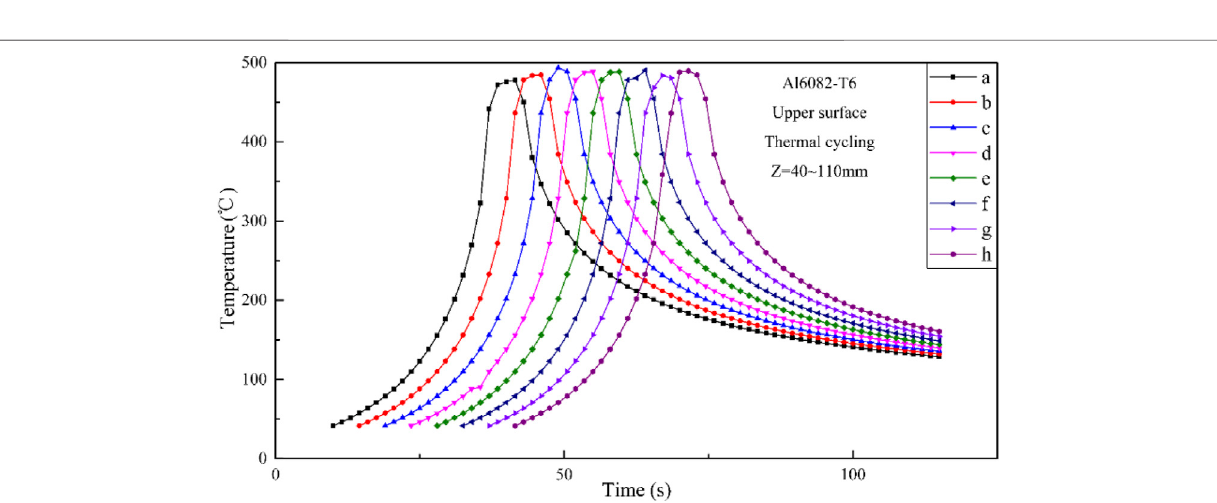
Frontiers in Materials |